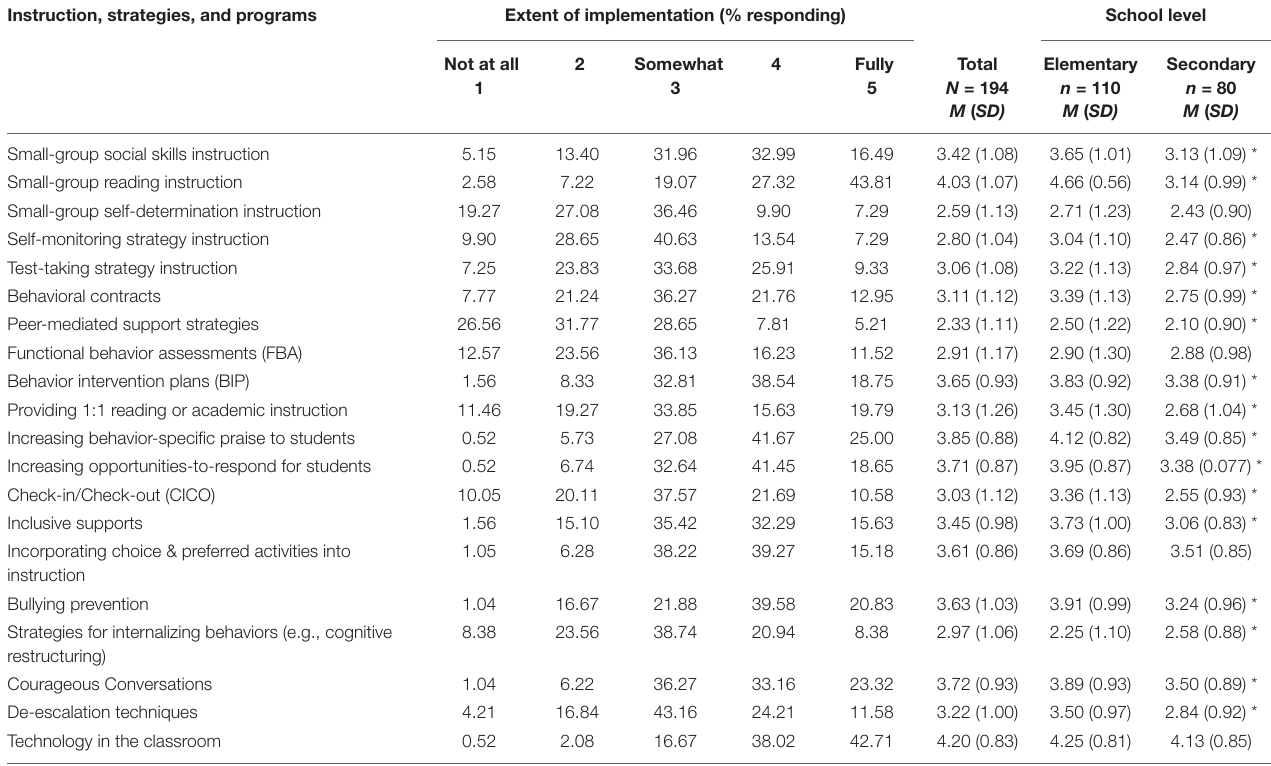
TABLE 3 | Educational practices and supports currently